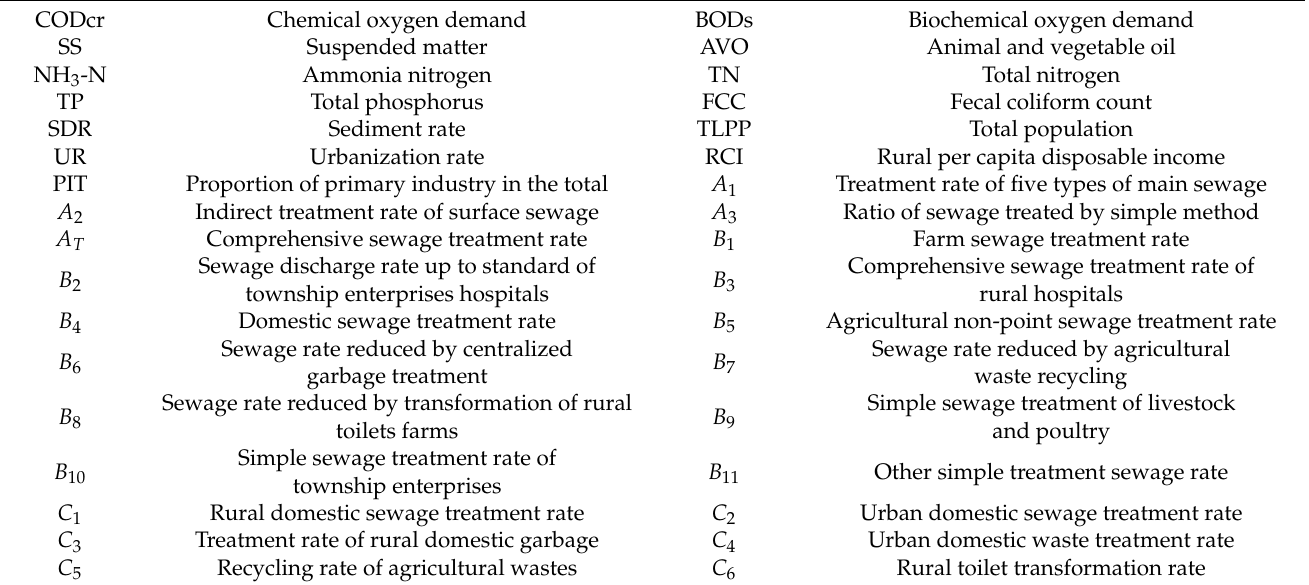
Table 1. Abbreviations of some indicator